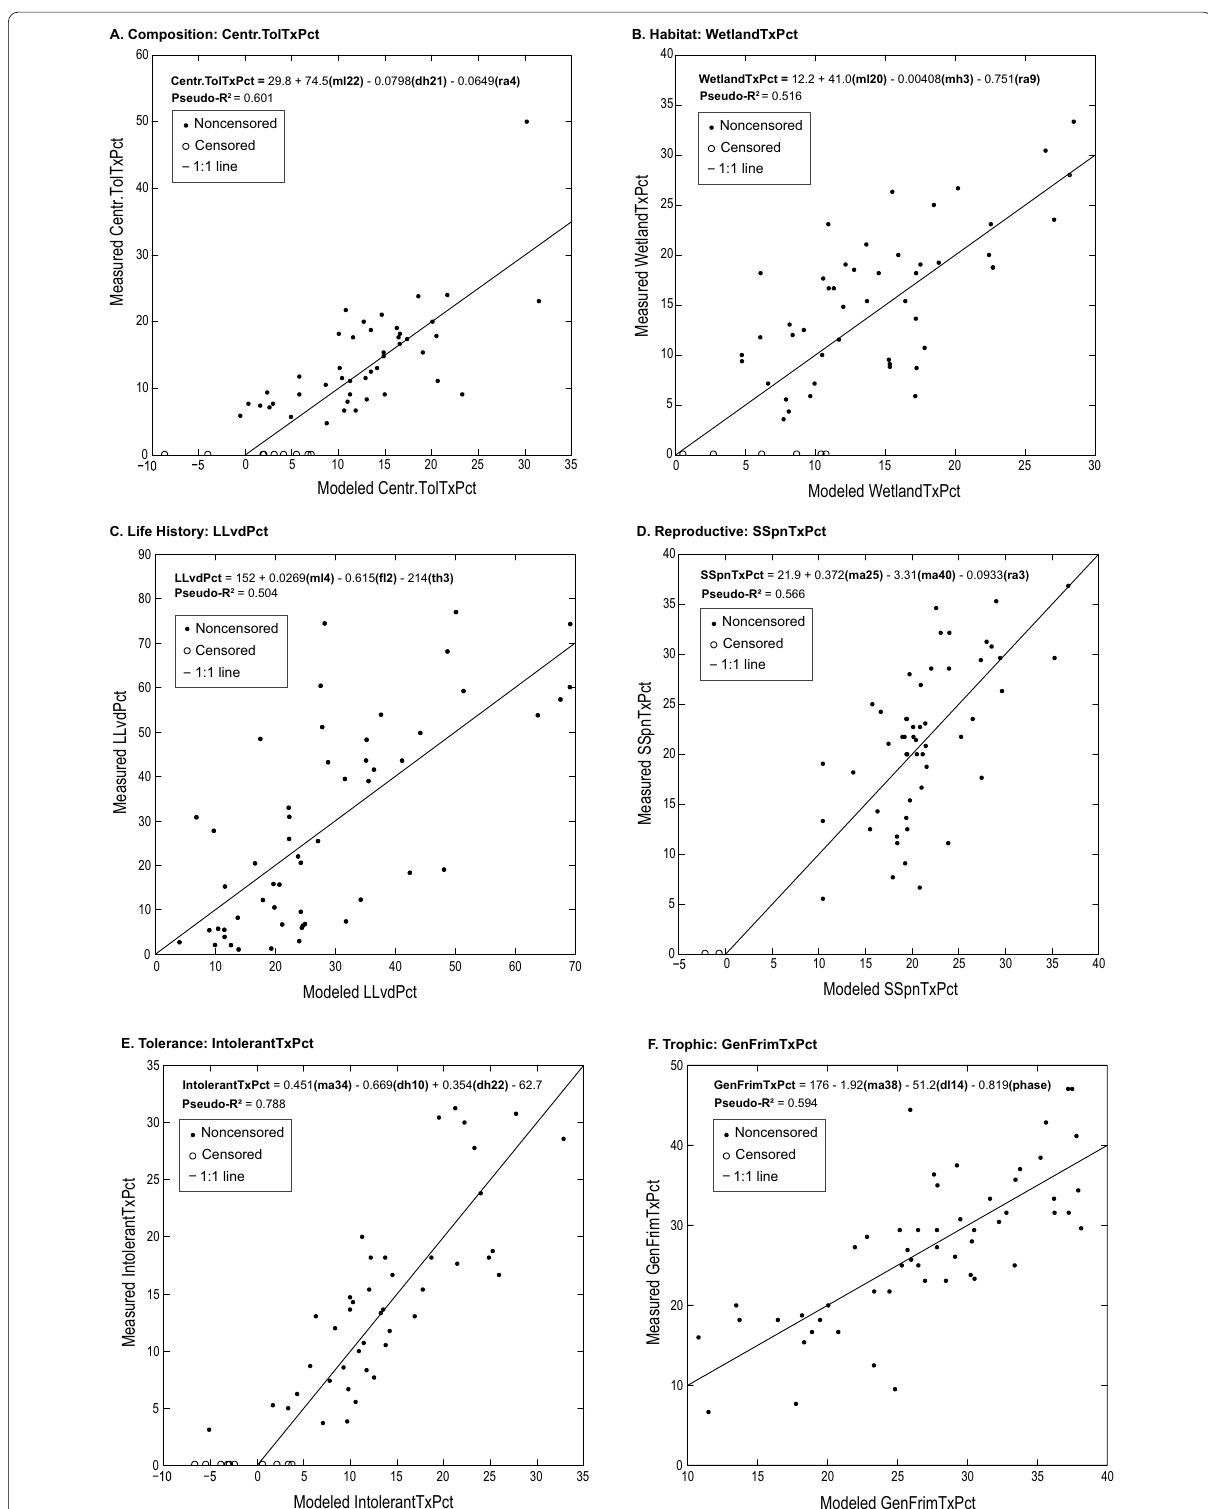
Fig. 3 Measured versus modeled value plots for the single best regression model in each of six biological metric categories and the period of record (POR) hydrologic dataset as presented in Table 4 (Krall et al. 2022): a composition, b habitat, c life history, d reproductive, e tolerance, and